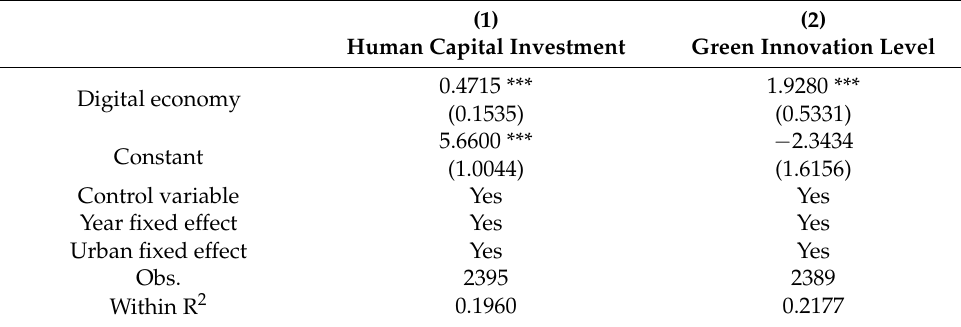
Table 5. Mechanism inspection